Question: In one sentence, what is this figure communicating?
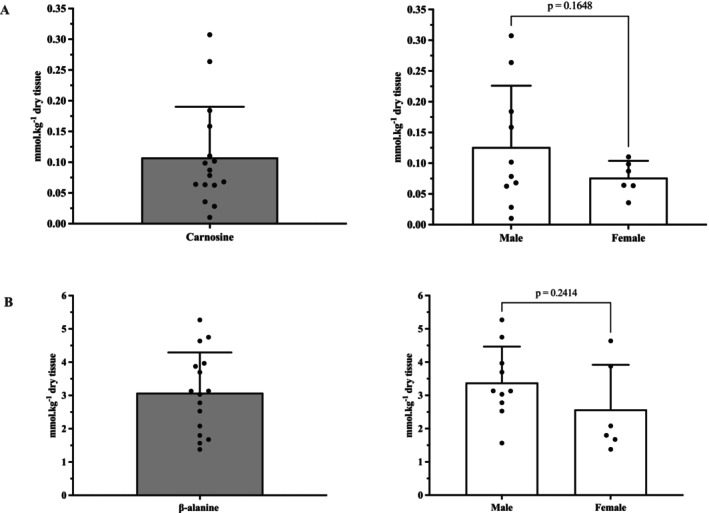
Answer: Carnosine (A) and β‐alanine (B) content in heart samples from all individuals grouped and separated by sex. Data are presented as mean ± 1 SD.